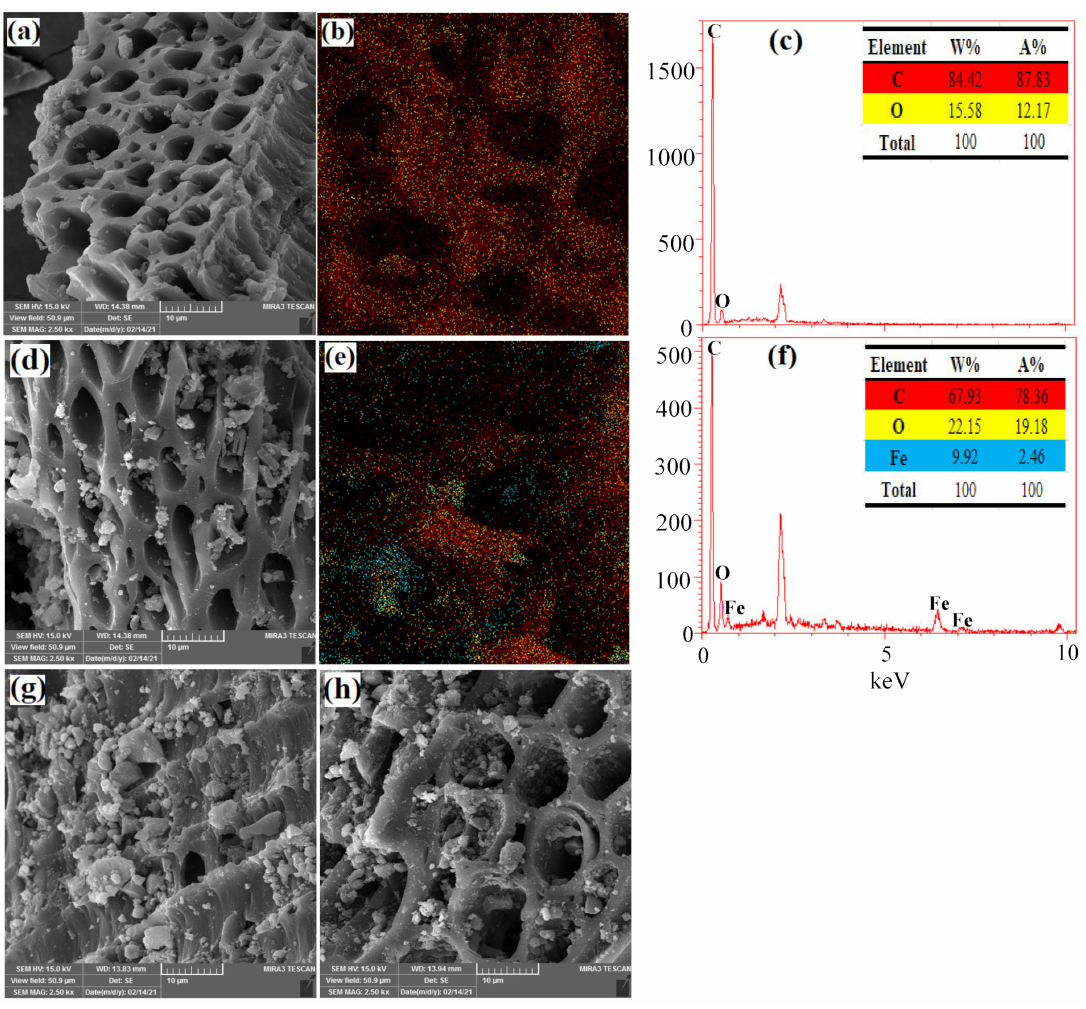
Figure 3. SEM, Map and EDX analyzes for: ( a – c ) ACL; ( d – f ) ACL/Fe 3 O 4 magnetic nanocomposite; ( g ) ACL after CV dye adsorption, and ( h ) ACL/Fe 3 O 4 magnetic nanocomposite after CV dye